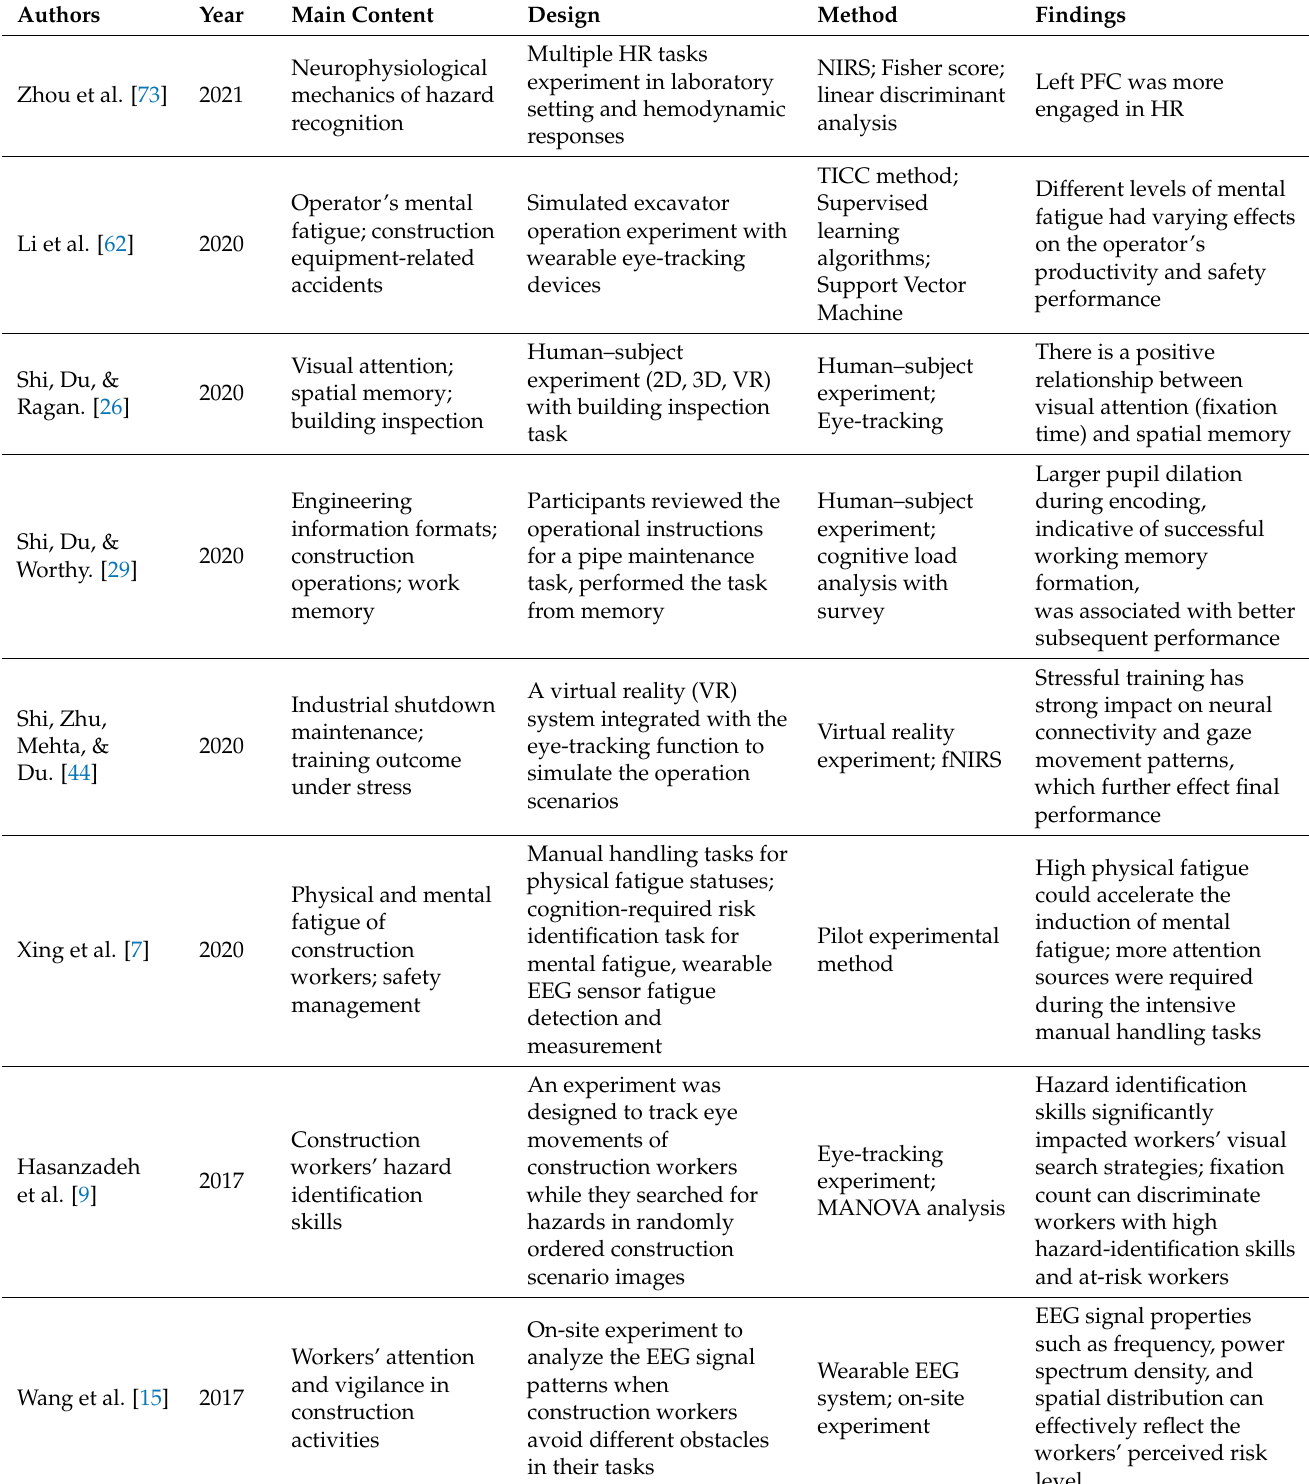
Table 4. Current research and main